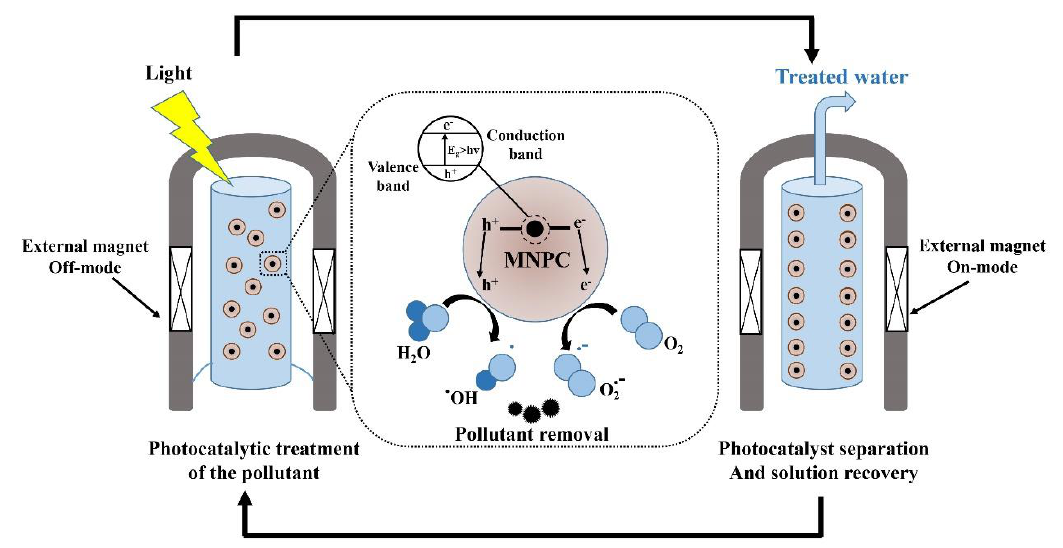
Figure 8. Schematic of the implementation of magnetic nanophotocatalysts (MNPCs) in water treatment. Reproduced from [173].